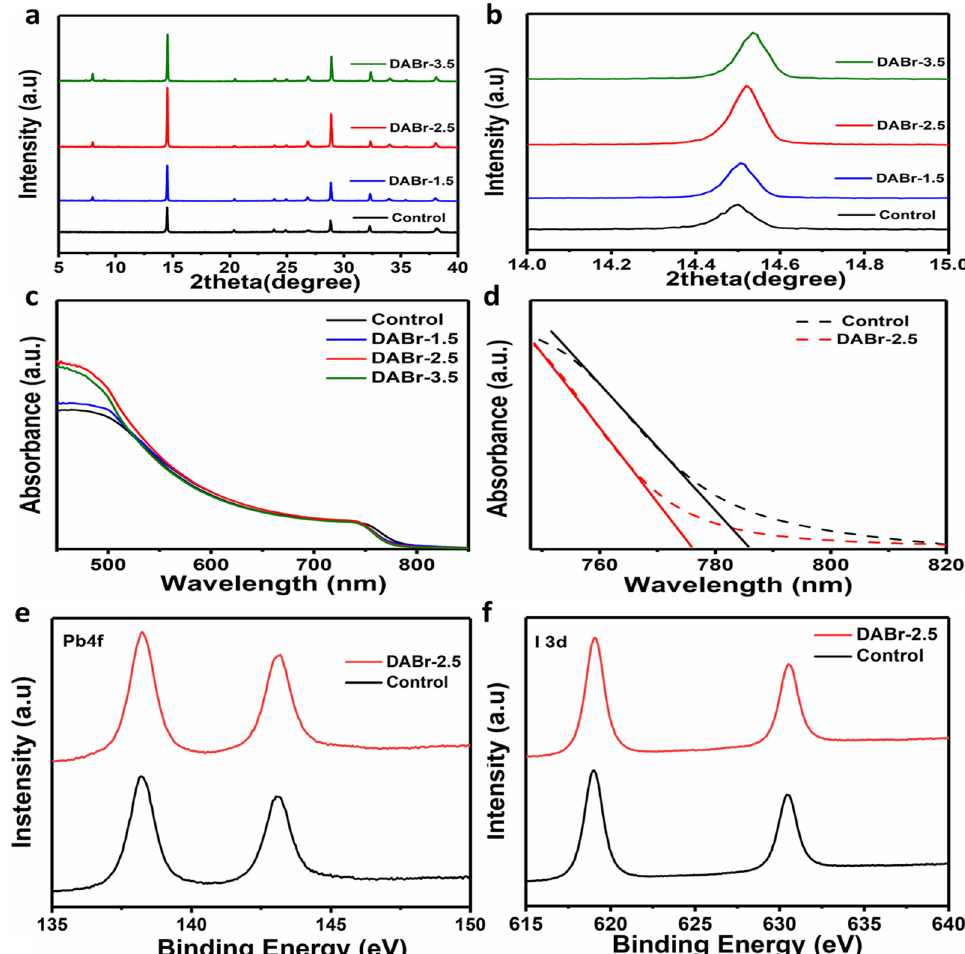
Figure 3. ( a ) X-ray diffraction (XRD) patterns and ( b ) extended XRD region of the films proccessed with different concentrations of DABr solution. ( c ) UV-vis absorption spectra of the control film and the films treated with different concentrations of DABr, ( d ) fingerprint region of UV-vis absorption spectra of the films. X-ray photoelectron spectroscopy (XPS) spectra of ( e ) Pb 4f and ( f ) I 3d for control and DABr-2.5-treated films.